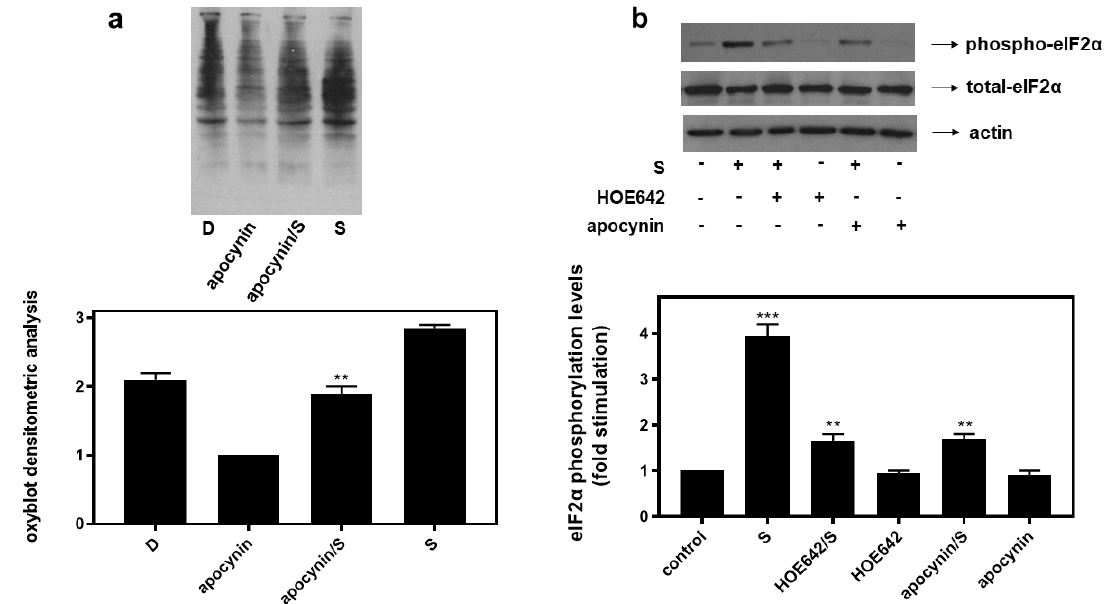
Figure 8. HOE642, a specific inhibitor of NH-1, as well as apocynin, an inhibitor of Nox, suppress hyperosmotic-stress-induced phosphorylation of eIF2 α in H9c2 cardiac cells. ( a ) Oxyblot analysis was performed in H9c2 cells exposed to Diamide (D), apocynin, apocynin followed by sorbitol in the presence of apocynin (apocynin/S) and 0.5 M sorbitol (S). After homogenization in RIPA buffer, lysates were incubated with DNPH and proteins were electrophoresed (SDS-PAGE) and immunoblotted with an anti-DNP antibody. Immunoreactive bands were quantified by scanning densitometry and plotted (( a ) respective graph). ( b ) H9c2 cells were left untreated (control) or were incubated with the inhibitors alone or with the inhibitors followed by exposure to 0.5 M sorbitol (S) in the presence of the inhibitors. Cell extracts (40 µ g/lane) were subjected to SDS-PAGE and immunoblotted with an antibody that detects phosphorylated eIF2 α (upper panel), total levels of eIF2 α (middle panel) as well as total levels of actin (bottom panel). Western blots are representative of at least three independent experiments with overlapping results. Immunoreactive bands were quantified by laser scanning densitometry and plotted (respective graph). Results are means ± SEM for at least three independent experiments. *** p < 0.001 compared to control values; ** p < 0.01 compared to sorbitol-treated cells in the absence of the